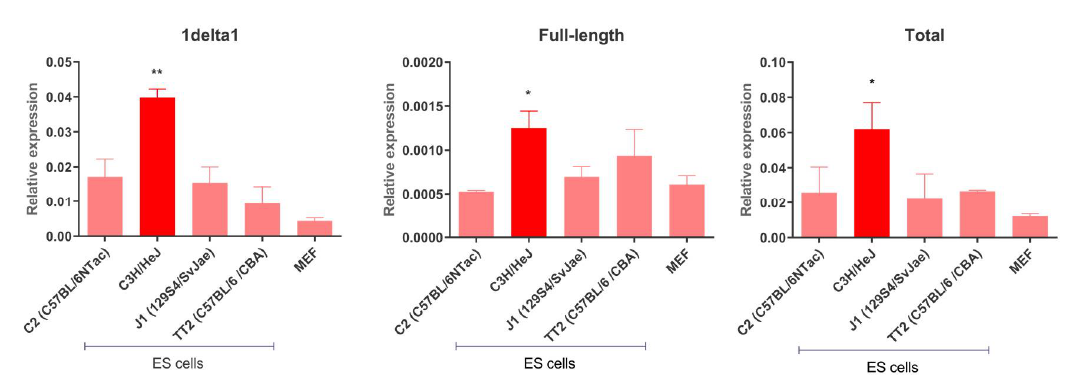
Figure 2. Steady-state levels of IAP transcripts in a panel of ES cells. Levels in MEFs are shown for comparison. Left panel shows 1 ∆ 1 transcript levels, middle panel shows transcripts of full-length copies and right panel shows total IAP expression. Dark red bars highlight the C3H / HeJ IAP steady-state level. Anova with Dunnett’s pos-hoc test was performed and standard deviation is shown. * p -value < 0.05, ** p -value < 0.005.